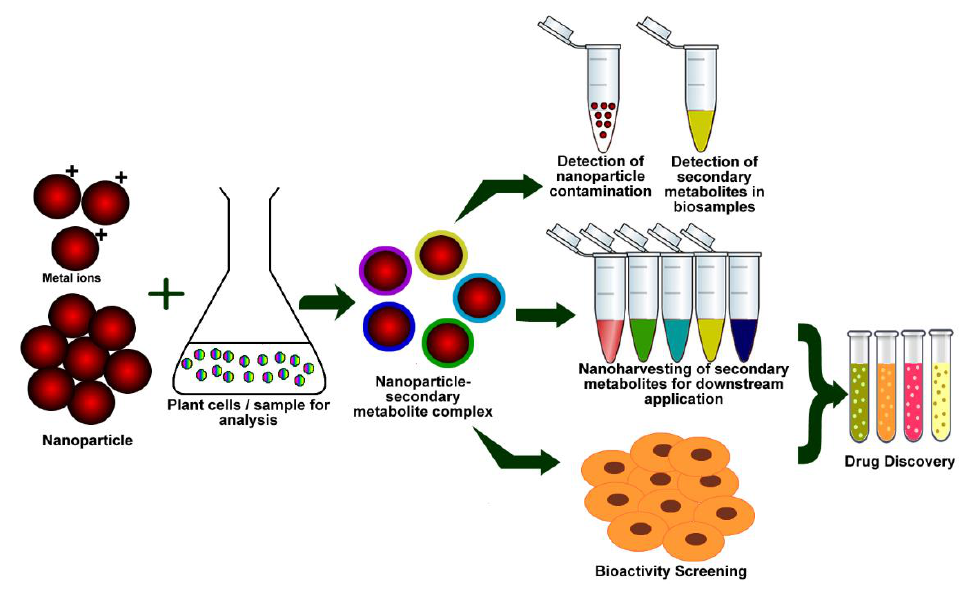
Figure 5. A scheme showing possible nanotrapping/nanoharvesting and drug discovery applications of green synthesis.